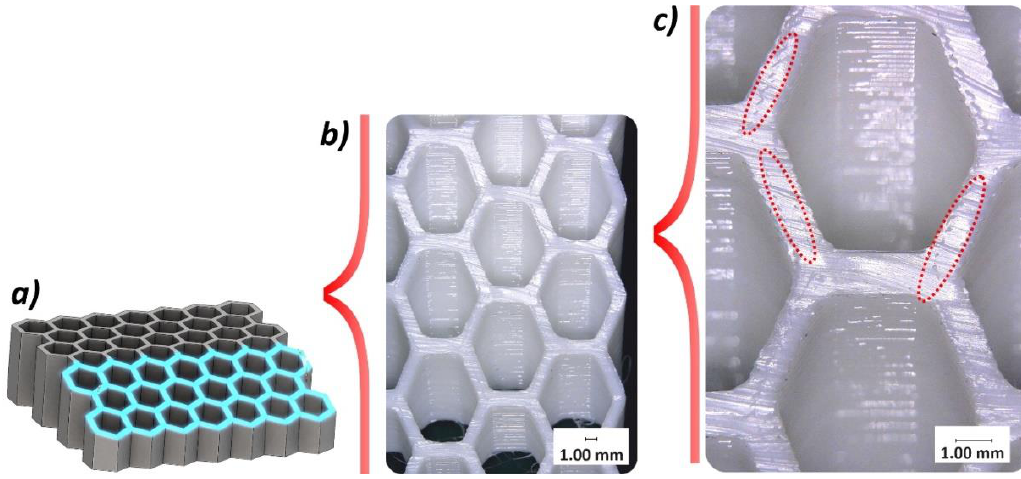
Figure 9. The angle sectional plane view of 3D printed honeycomb specimen: ( a ) 3D CAD model with sectional plane, ( b ) general view of specimen, ( c ) view with magnitude ×20.